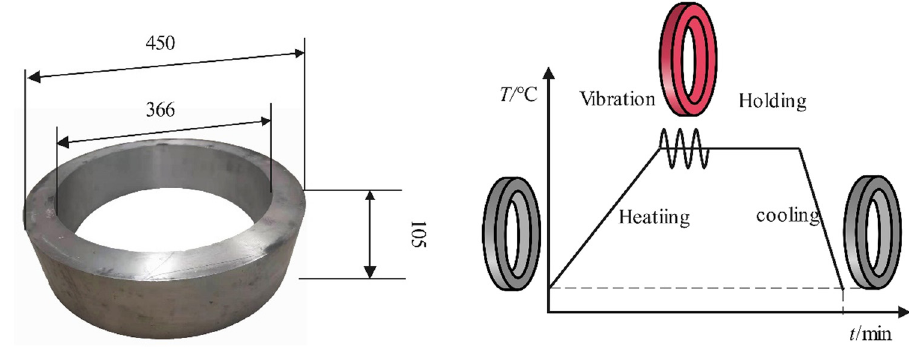
Figure 1: The 2219 aluminum alloy ring and general TVSR processes.